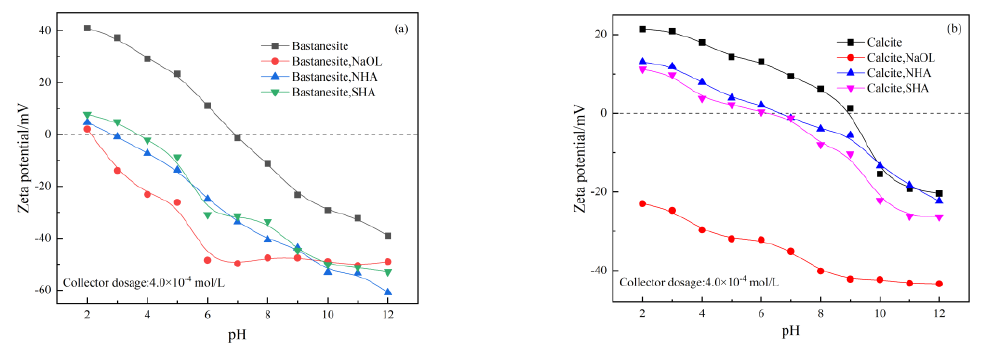
Figure 5. Zeta potential measurement results of bastnaesite ( a ) and calcite ( b ).